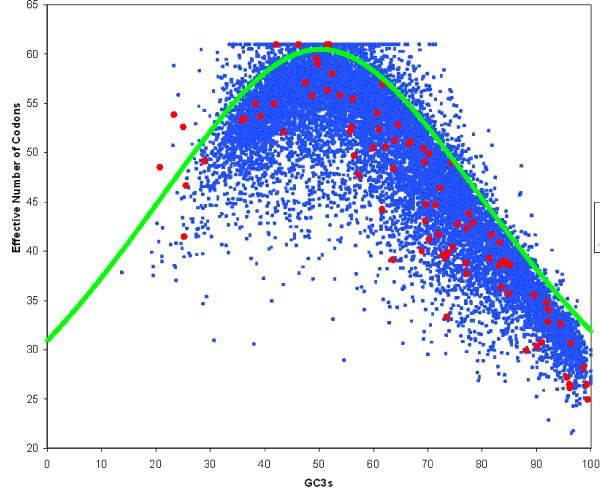
The effective number of codons (Nc) plotted for 14005 rice genes. The ribosomal protein genes highlighted in red. The GC(ref) line – shown in green – is the expected position of genes whose codon usage is only determined by the GC content at the third positions of codons (GC3s).